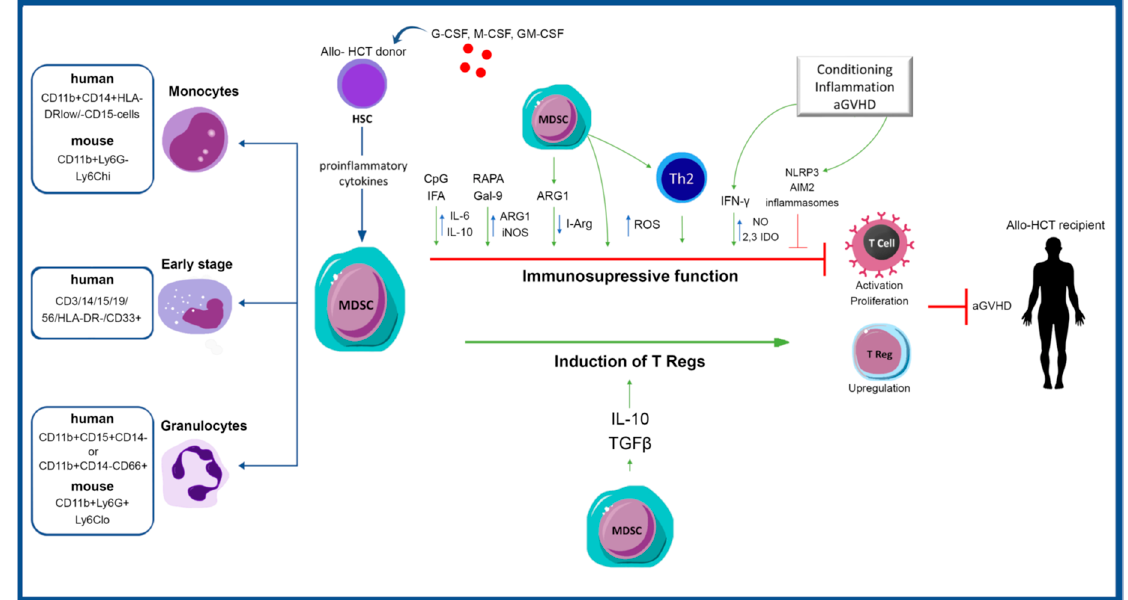
Figure 1. Implications of MDSCs in GVHD. Myeloid-derived suppressor cells (MDSCs) are generated under inflammatory conditions. Inflammatory factors that induce MDSC recruitment and expansion include GM-CSF, G-CSF, M-CSF, and proinflammatory cytokines. Three different subsets of MDSCs have been identified according to their cellular markers; granulocytes, monocytes, and early stage MDSCs. The role of MDSC in the pathogenesis of GVHD would be beneficial through two mechanisms: (1) Immunosuppressive activity of MDSCs by regulating the secretion of various factors, among which ARG1, iNOS, and IDO; (2) Induction and expansion of T Regs. GM-CSF, granulocyte–macrophage colony- stimulating factor; G-CSF, granulocyte colony-stimulating factor; M-CSF, macrophage colony-stimulating factor; HSC, hematopoietic stem cells; HCT, hematopoietic cell transplantation; IFA, incomplete Freund’s adjuvant; RAPA, rapamycin; Gal-9, galectin-9; I-Arg, L-arginine; IFN- γ , interferon gamma; NO, nitric oxide; NLRP3, NLR pyrin family domain 3; AIM2, absent in melanoma 2; aGVHD, acute Graft-versus-Host Disease; ARG1, arginase 1; iNOS, inducible nitric oxide synthase; IDO, indoleamine 2,3-dioxygenase; ROS, reactive oxygen species; TGF β , transforming growth factor beta; IL-6, IL-10, interleukin-6, interleukin-10.